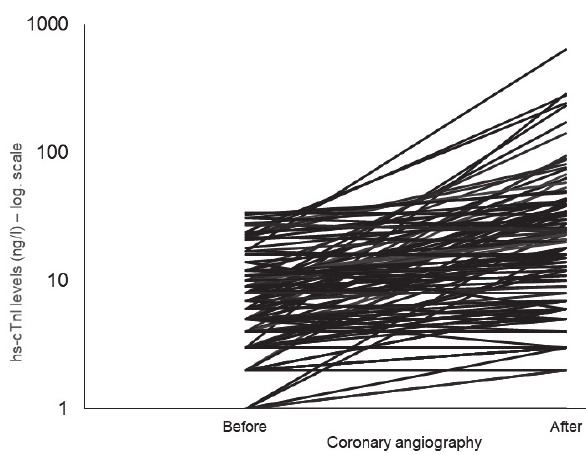
Fig. 1. Absolute change in hs-cTnI levels in patients with ini- tially negative values (n =